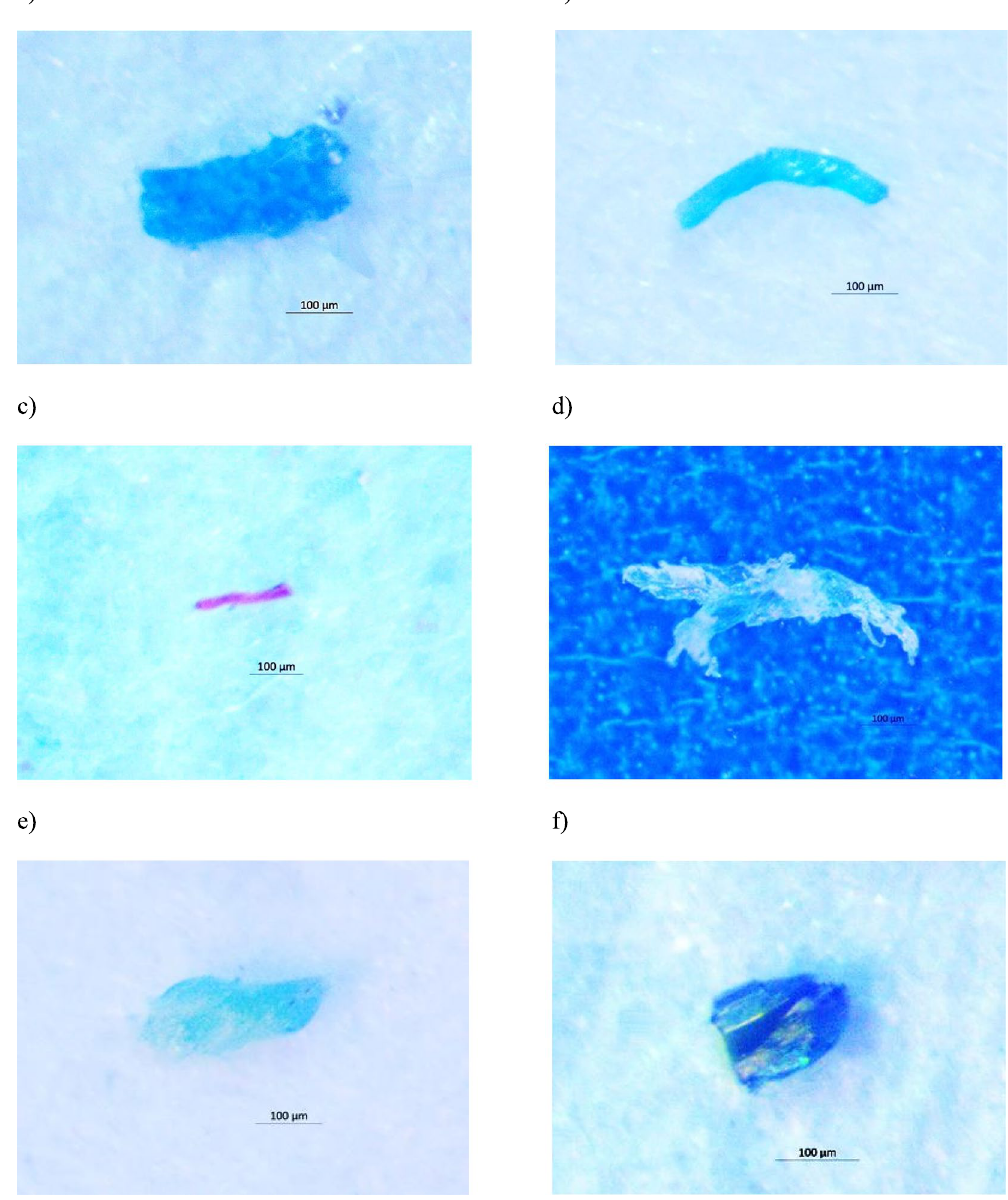
Figure 3. Isolated particles from dried fish. These particles were identified using micro-Raman spectroscopy as ( a ) Phthalocyanine, ( b ) Polypropylene + Phthalocyanine, ( c ) Polyethylene terephthalate, ( d ) Polyethylene, ( e ) Hostasol green, and ( f )